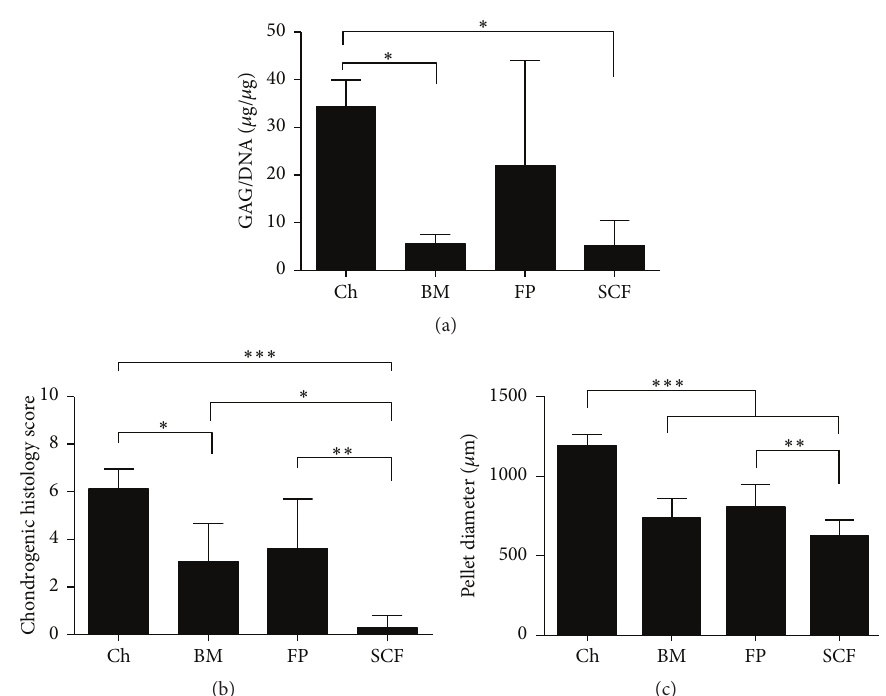
Figure 4: Chondrogenic assessments of pellet cultures across cell types. (a) Production of GAG/DNA in pellet cultures from chondrocytes (Ch), bone marrow MSC (BM), fat pad MSC (FP), and subcutaneous fat MSC (SCF) for all donors combined. (b) Chondrogenic histology scores for Ch, BM, FP, and SCF for all donors combined. (c) Mean chondrogenic pellet diameter ( 𝜇 m) for Ch, BM, FP, and SCF for all donors combined. Data shown are the means ± the standard deviation of triplicate pellets and 5 donors for each cell population. One-way ANOVA and post hoc Bonferroni tests were used to test for significant differences between cell